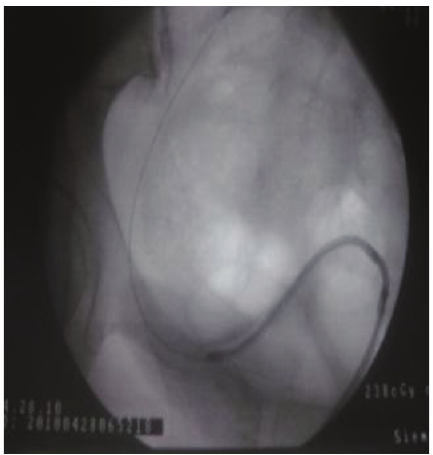
Figure 4: Laser incision of the diverticular